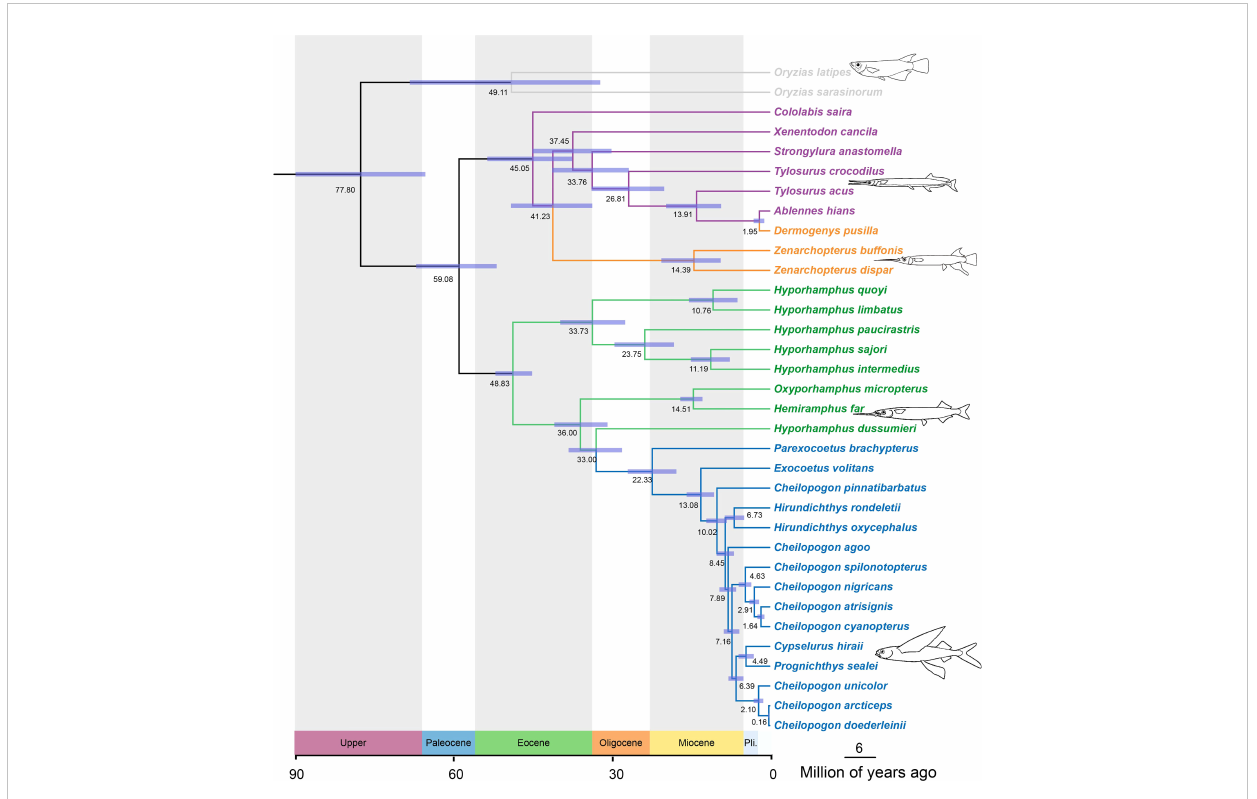
FIGURE 2 Beloniformes fi shes divergence time estimation performed by using MCMCTree on the RAxML topology. Node bars indicate 95% credible intervals of the divergence time estimates. Node labels are the estimates of the mean divergence times (in